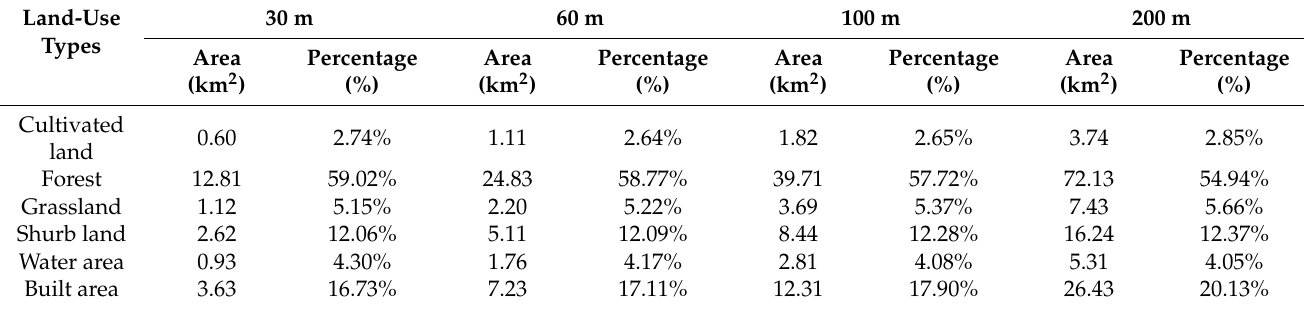
Table 9. Land-use type analysis of corridors with different